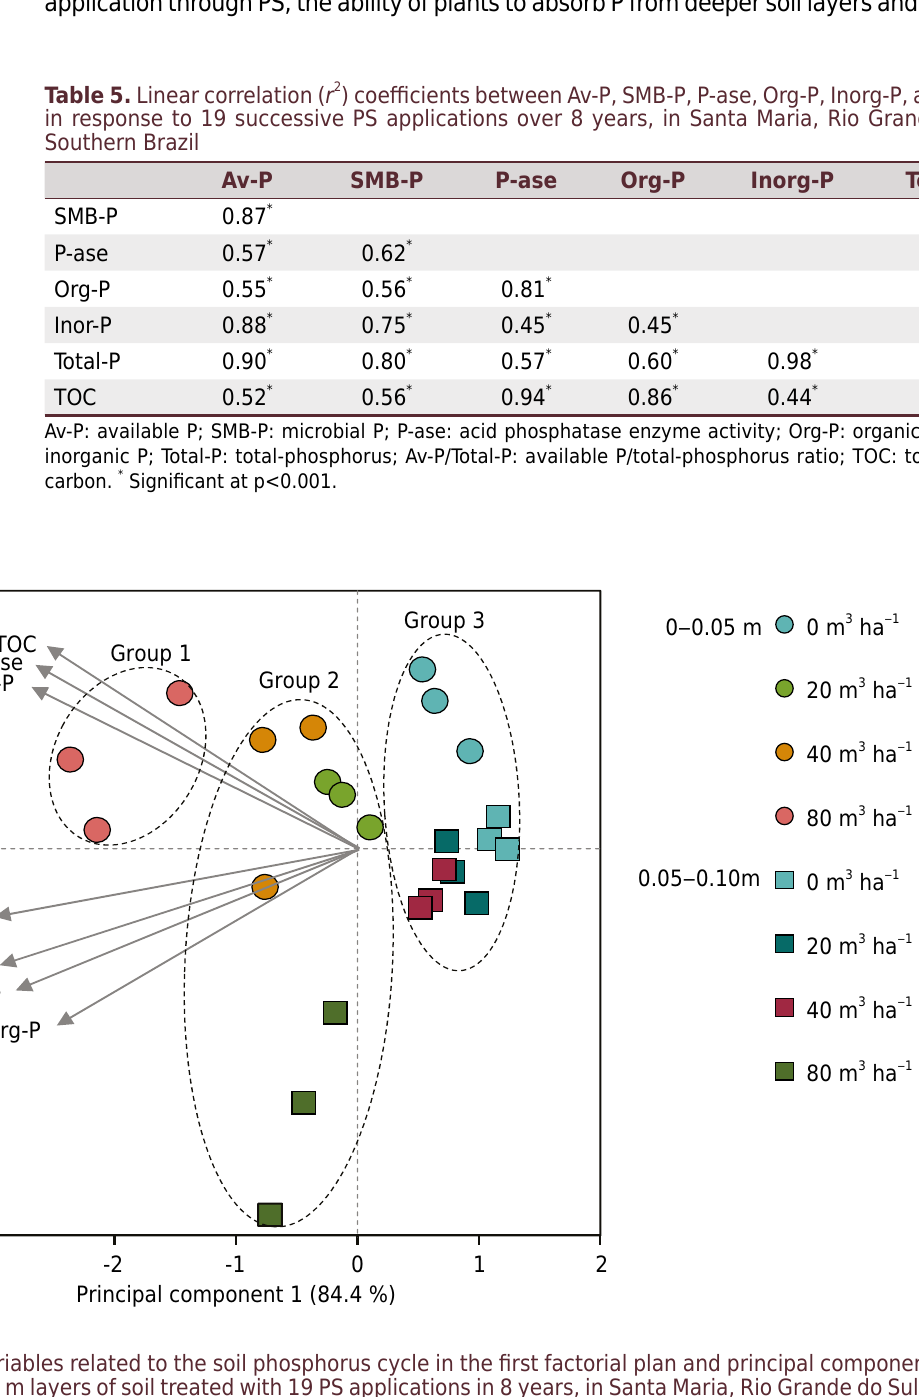
Figure 4. Projection of the variables related to the soil phosphorus cycle in the first factorial plan and principal component analysis of the 0.00-0.05 and 0.05-0.10 m layers of soil treated with 19 PS applications in 8 years, in Santa Maria, Rio Grande do Sul, Southern Brazil. Numbers in parentheses indicate percent of variation explained by each axis. Av-P: available phosphorus; SMB-P: microbial phosphorus; P-ase: acid phosphatase enzyme activity; Org-P: organic phosphorus; Inorg-P: inorganic phosphorus; Total-P: total- phosphorus; Av-P/Total-P: available phosphorus/total-phosphorus ratio; TOC: total organic